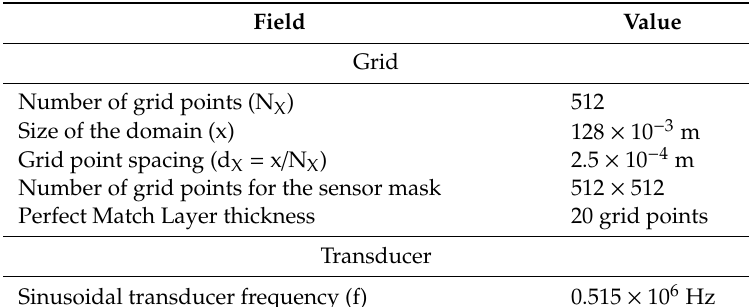
Table A1. Summary of the simulation inputs for relationships estimation of the axicon lens angle and the optimum stand-o ff